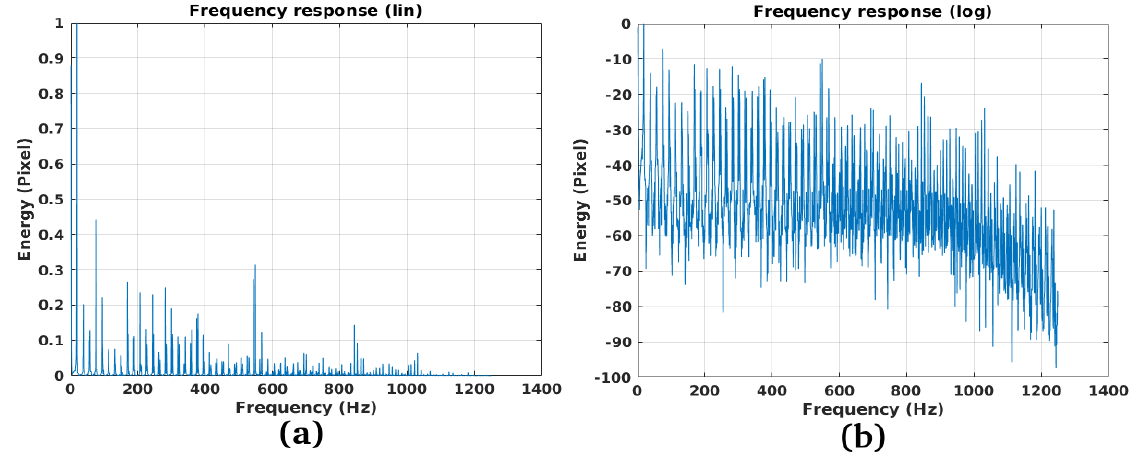
Figure 21. Vibration spectrum trends (DFT of Figure 20): ( a ) Linear trend, ( b ) Logarithmic